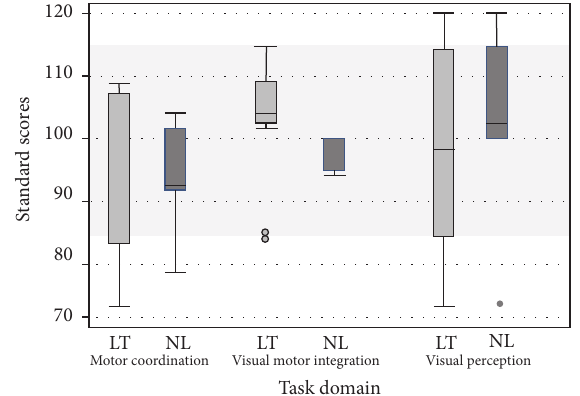
Figure 1: Beery VMI score results between LT and NL groups.